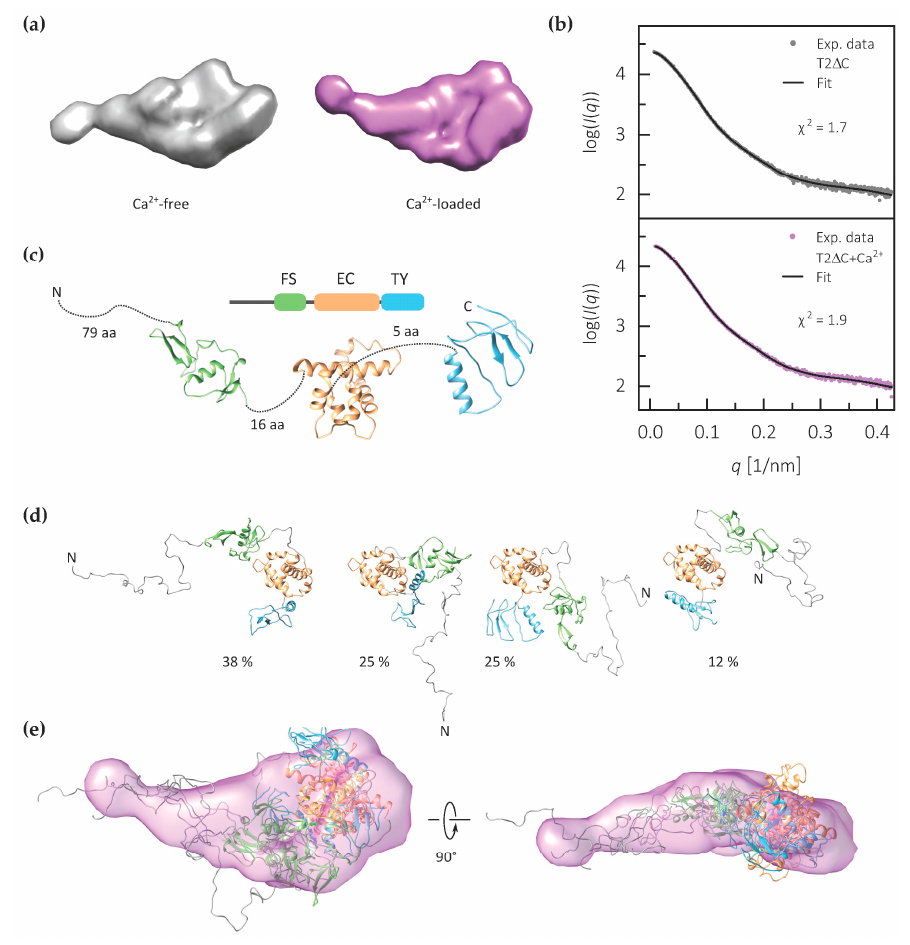
Figure 4. Structural models C-terminally truncated testican-2 based on SAXS data. ( a ) Ab initio molecular envelope of calcium-free and calcium-loaded T2 ∆ C generated using DAMMIF + DAMAVER with ( b ) corresponding fit to the experimental data ( χ 2 ). ( c ) Schematic representation of testican-2 structure with corresponding domain homology models. ( d ) Individual models of T2 ∆ C from